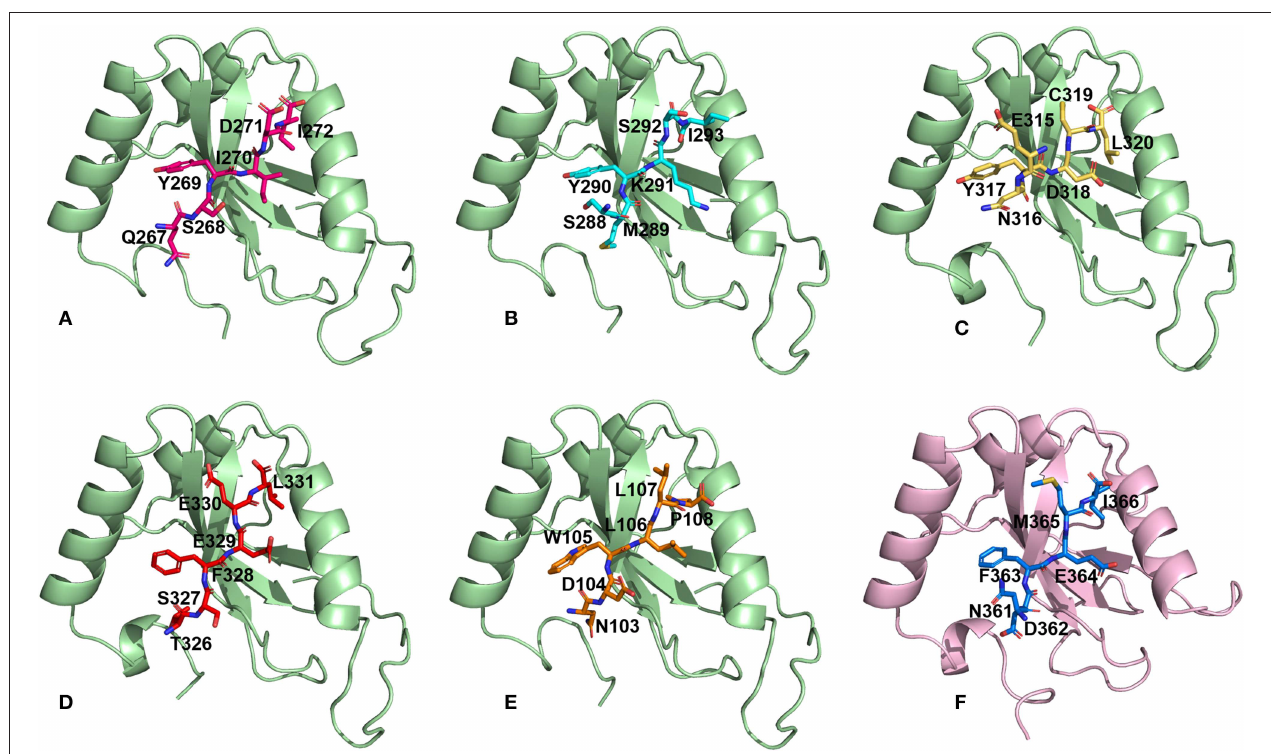
dPCA. Table 1 details the total number of conformations obtained post-dPCA analysis for all the six peptide-protein